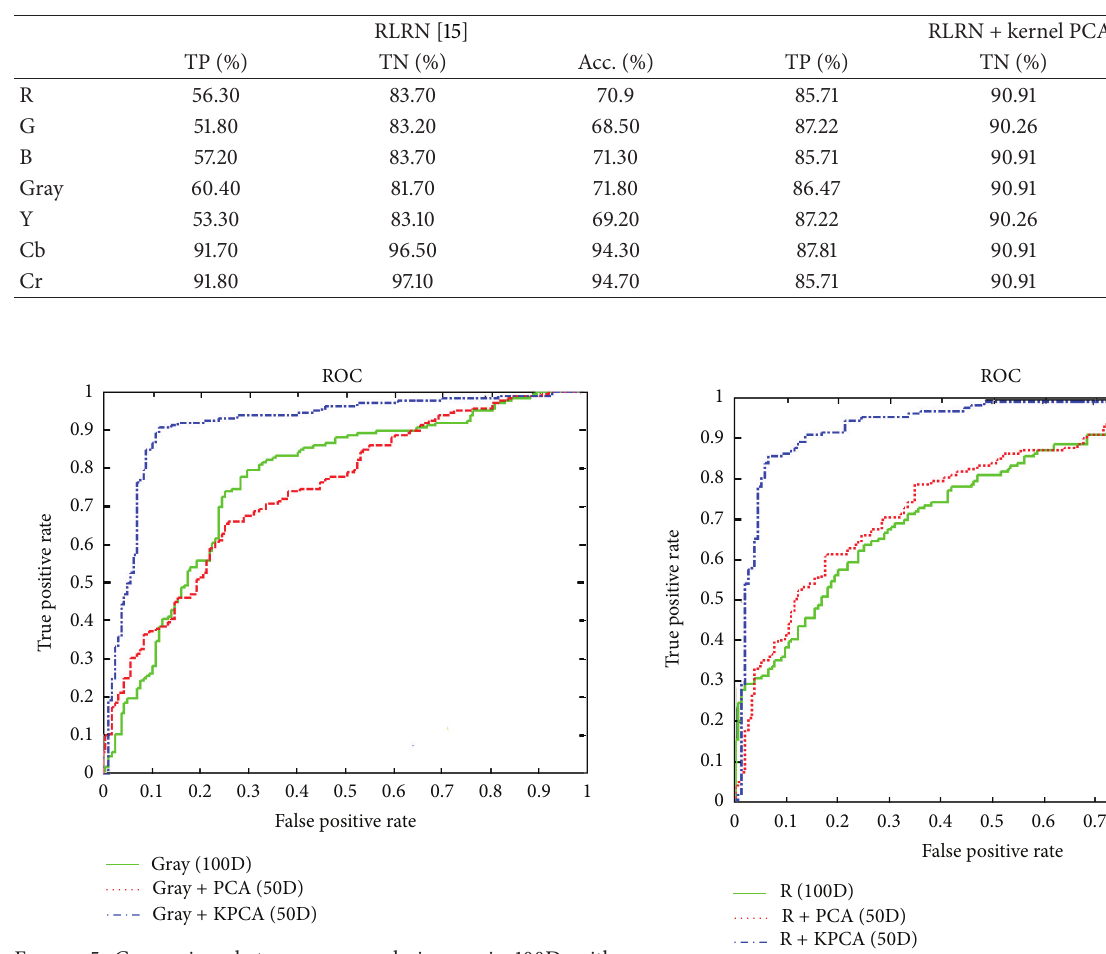
Table 5: Comparison between the original RLRN [15] and the proposed method (RLRN + kernel PCA).